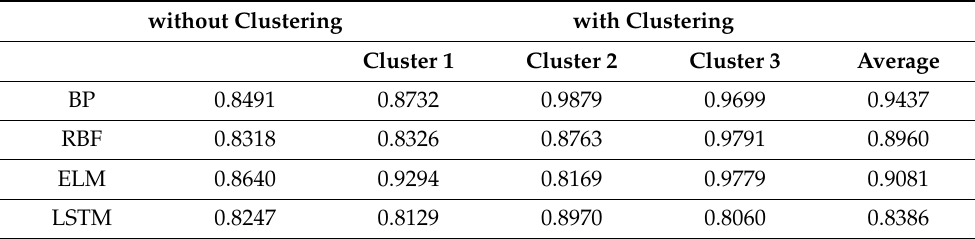
Table 9. R 2 of solar radiation in spring.